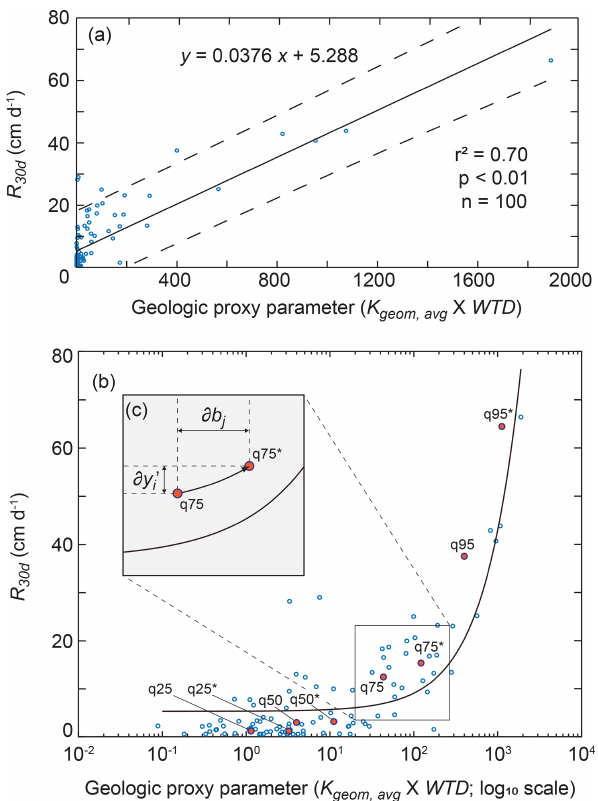
Figure 7. (a) Regression relation between the geologic proxy pa- rameter ( K geom × WTD) and the 30d average recharge rate ( R 30d ) for all exploratory simulations shown with a solid black line, where dashed lines indicate the upper and lower 95% confidence inter- vals. (b) The relation is shown with K geom × WTD on a log 10 scale, where red circles indicate the original and perturbed sites at which dimensionless scaled sensitivity (DSS) was estimated. (c) The in- set illustrates the procedure for estimating the perturbed site (e.g., q75 ∗ ) from the original site (e.g., q75) for DSS, using the regression relation, where ∂y (cid:48) is the change in K geom × WTD and ∂b j is the i estimated corresponding change in R 30d .